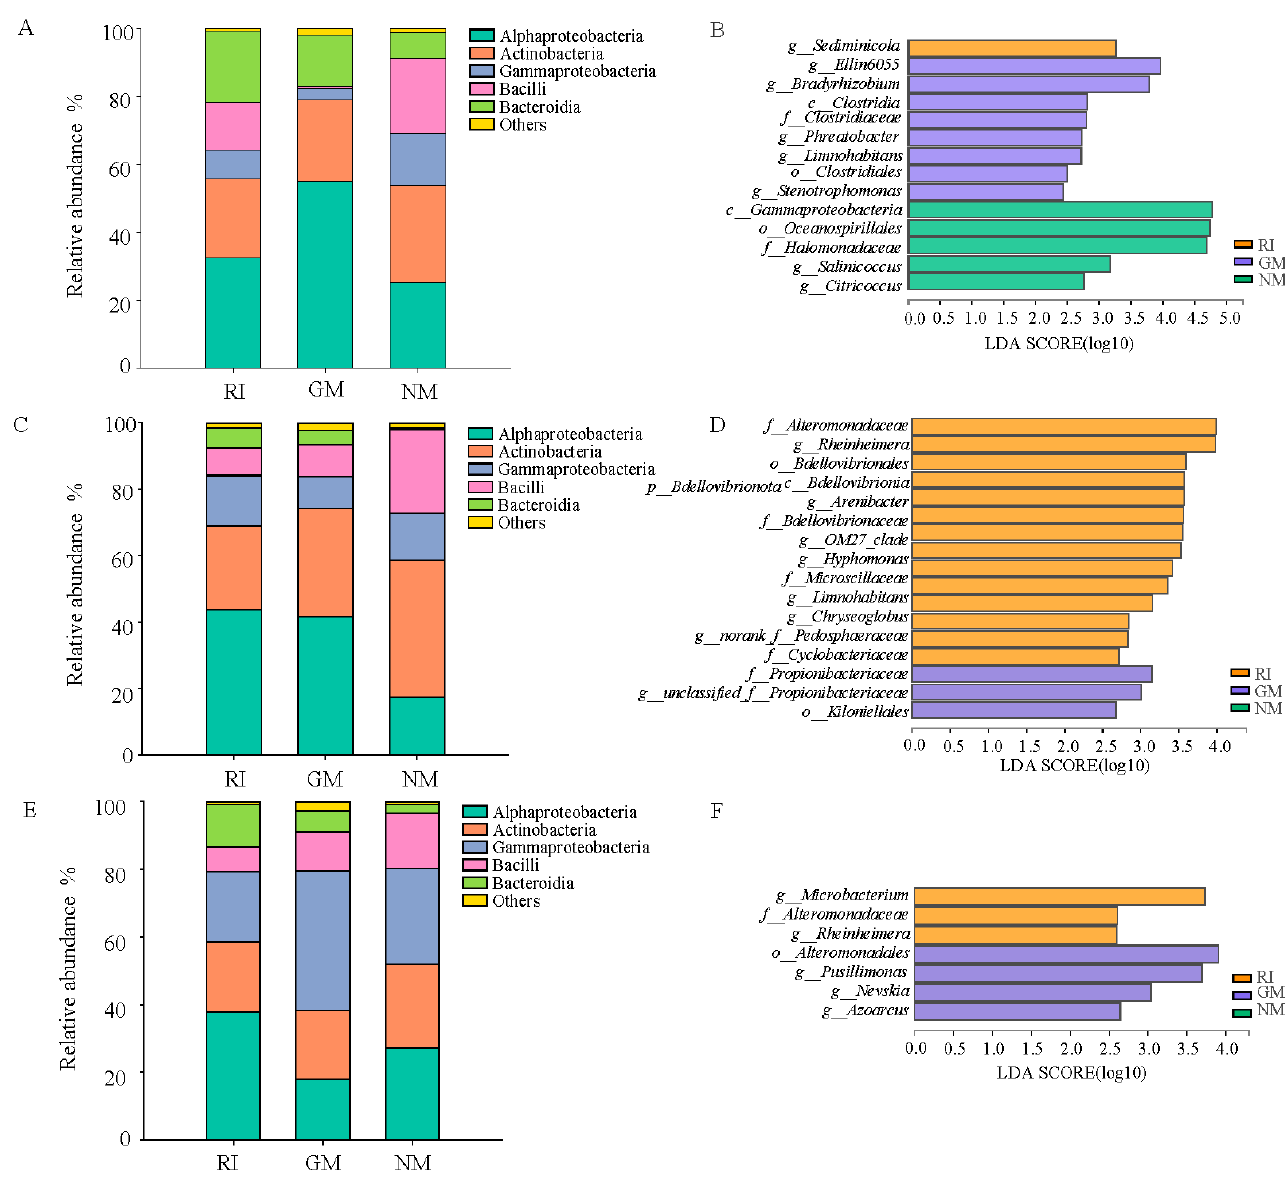
Figure 3. Bacterial community compositions at class level ( A , C , E ), and significantly different bacterial groups ( B , D , E ) in litters of I. cylindrica as influenced by AMF and heavy metal.